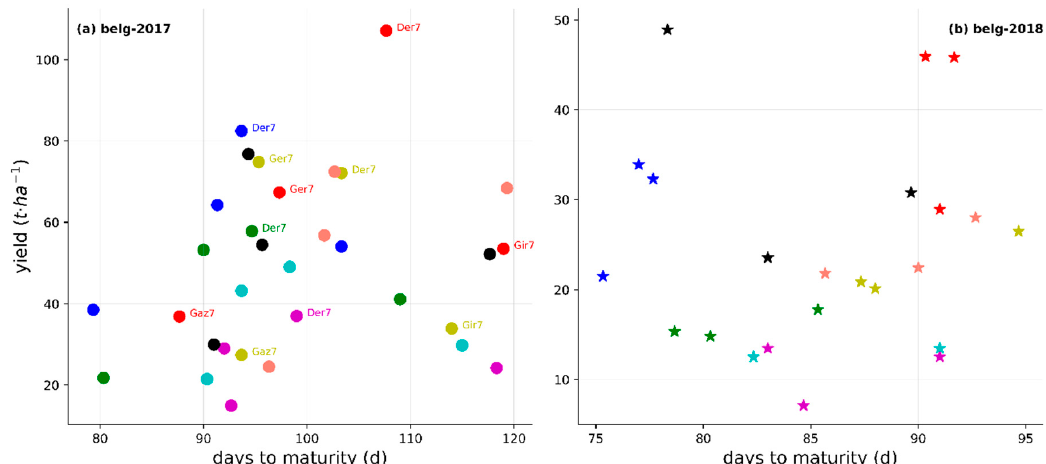
Figure 9. Variations in the observed yield (t · ha − 1 ) for eight cultivars as a function of days to crop maturity (d). The colors represent cultivars in four locations (Gaz7—Gazesso, Ger7—Geresse, Der7—Derashe, and Gir7—Gircha) in belg -2017 ( a ) and six locations in belg -2018 ( b ). Note that the x and y-axes ranges are di ff erent for both panels; and the colors (e.g., red dots and line— Belete and yellow dots and line— Suthalo ) represent a cultivar in di ff erent farms.